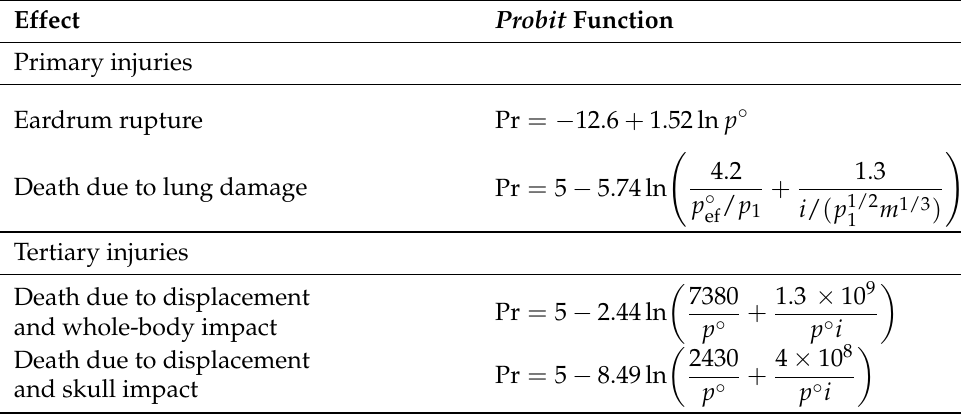
Table 3. Probit functions used to estimate the probability of different types of primary and tertiary injuries. Pr is the probit value, p ◦ [Pa] the peak overpressure, p ◦ overpressure, depending on the relative orientation of the person with respect to the shock wave, p 1 [Pa] the atmospheric pressure, I / A [Pa · s] the impulse per unit area and m [kg] the weight of the person